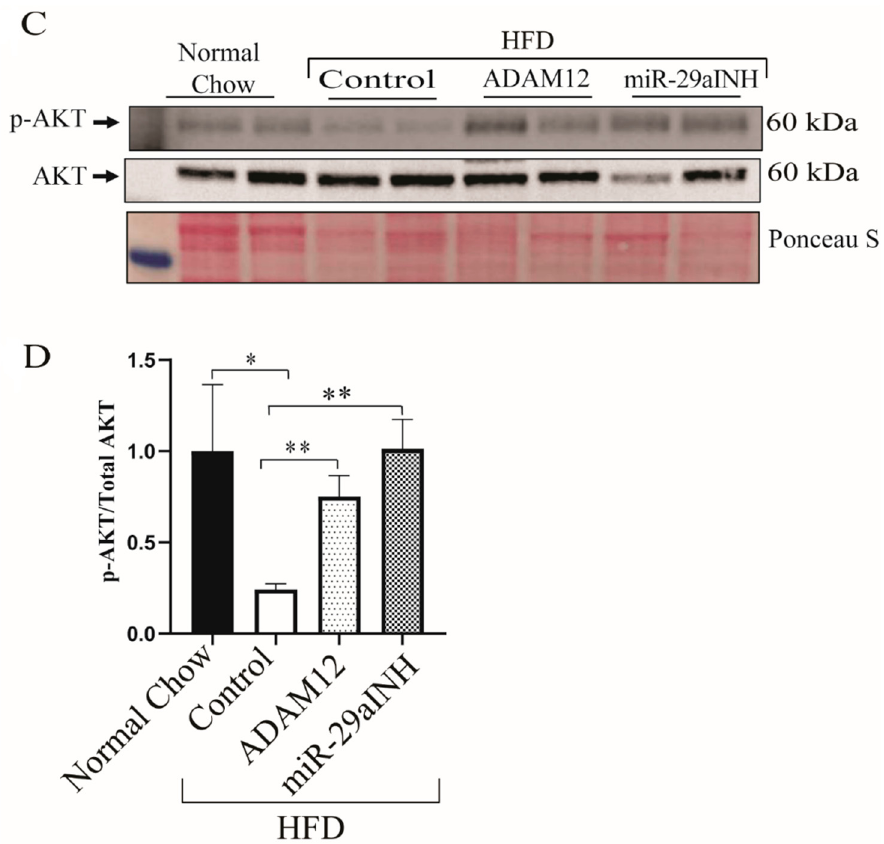
Figure 6. miR-29a inhibition and ADAM12 augmentation modulates Tie2 cleavage through increased Akt phosphorylation (p-AKT) in vivo: ( A ): Tie2 cleavage western showing higher expression of cleaved Tie2 in GA lysates from mice with type 2 diabetes hindlimbs that received miR-29aINH (HFD + miR-29aINH) and ADAM cDNA (HFD + ADAM12) compared with those that received control plasmid (HFD Control), 3 days post-HLI. ( B ): Quantification of Western blot bands ( n = 6, * p < 0.05, ** p < 0.005 and Normal Chow: n = 6, HFD Control: n = 6, HFD + ADAM12: n = 7 and HFD + miR29aINH: n = 8). ( C ): Akt and p-Akt Western showing higher expression in muscle lysates from mice with type 2 diabetes hindlimbs that received miR-29aINH (HFD + miR-29aINH) and ADAM cDNA (HFD + ADAM12) compared with those that received control plasmid (HFD Control), 3 days post-HLI. ( D ): Quantification of Western blot bands (* p < 0.05, ** p < 0.005 and Normal Chow: n = 6, HFD Control: n = 6, HFD + ADAM12: n = 7 and HFD + miR29aINH: n =